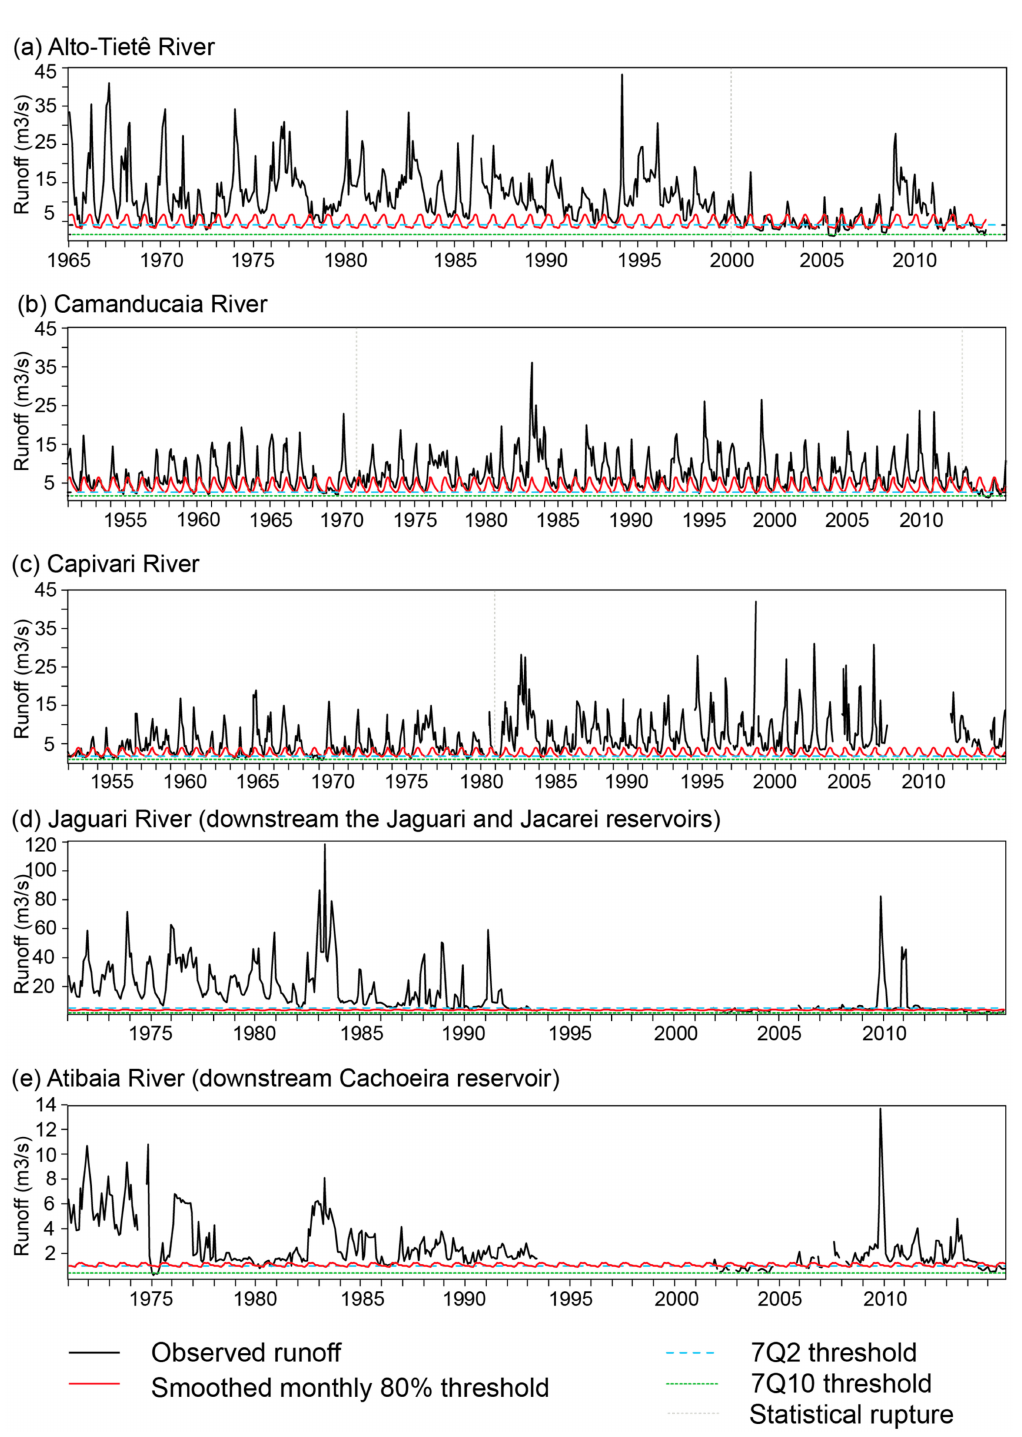
Figure 7. Observed monthly runoff series of the Alto-Tiet ê River (Alto-Tiet ê basin) and the Camanducaia, Capivari, Jaguari and Atibaia rivers (PCJ basin) compared to three threshold values (80th percentile of monthy flow duration curves, 7Q2 and 7Q10) in order to capture hydrological anomalies (i.e., when observed runoff values are lower than the threshold values). Statistical ruptures identified in Section 4.2 are also